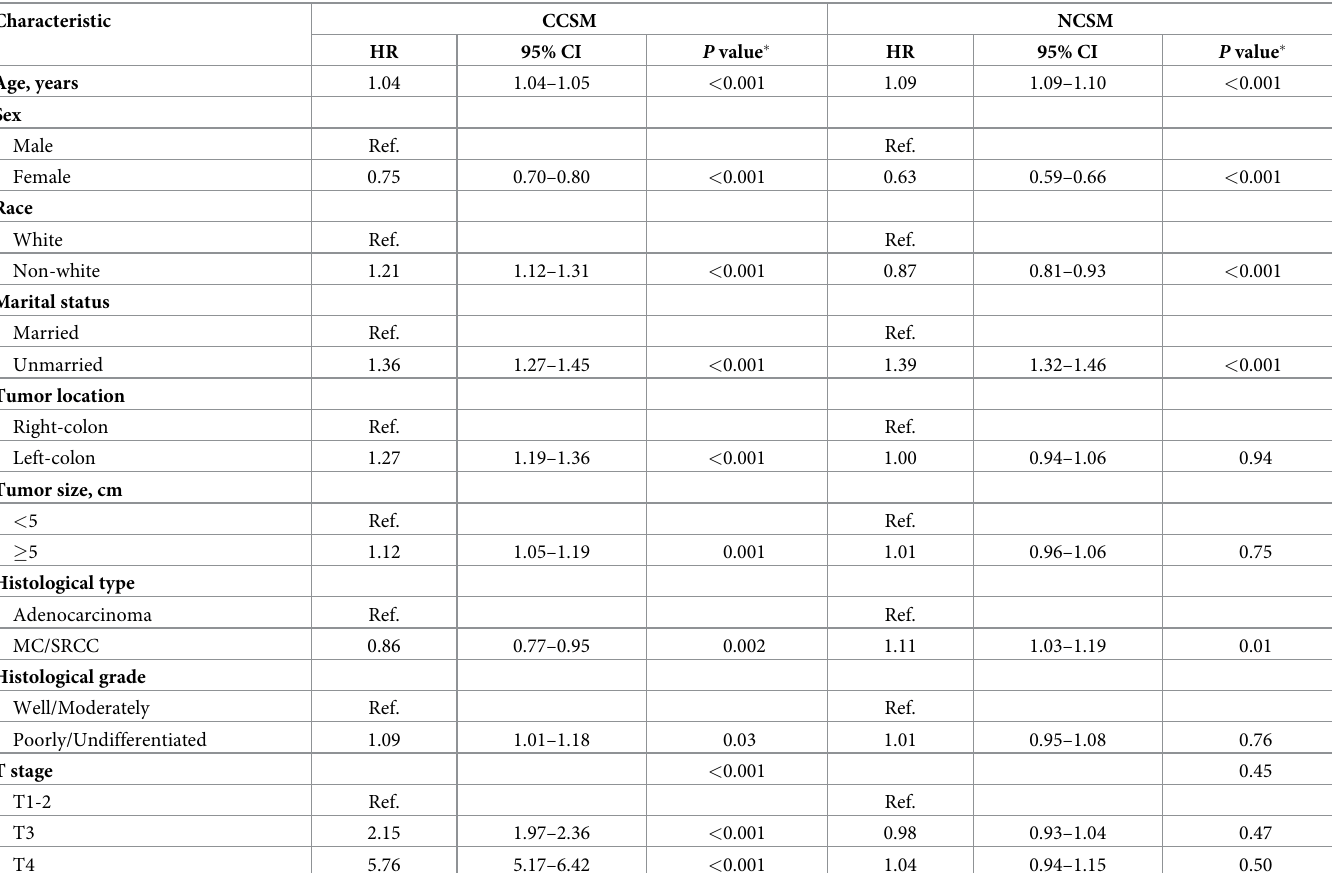
Table 3. Multivariable cause-specific hazard models for CCSM and NCSM in stage I/II colon